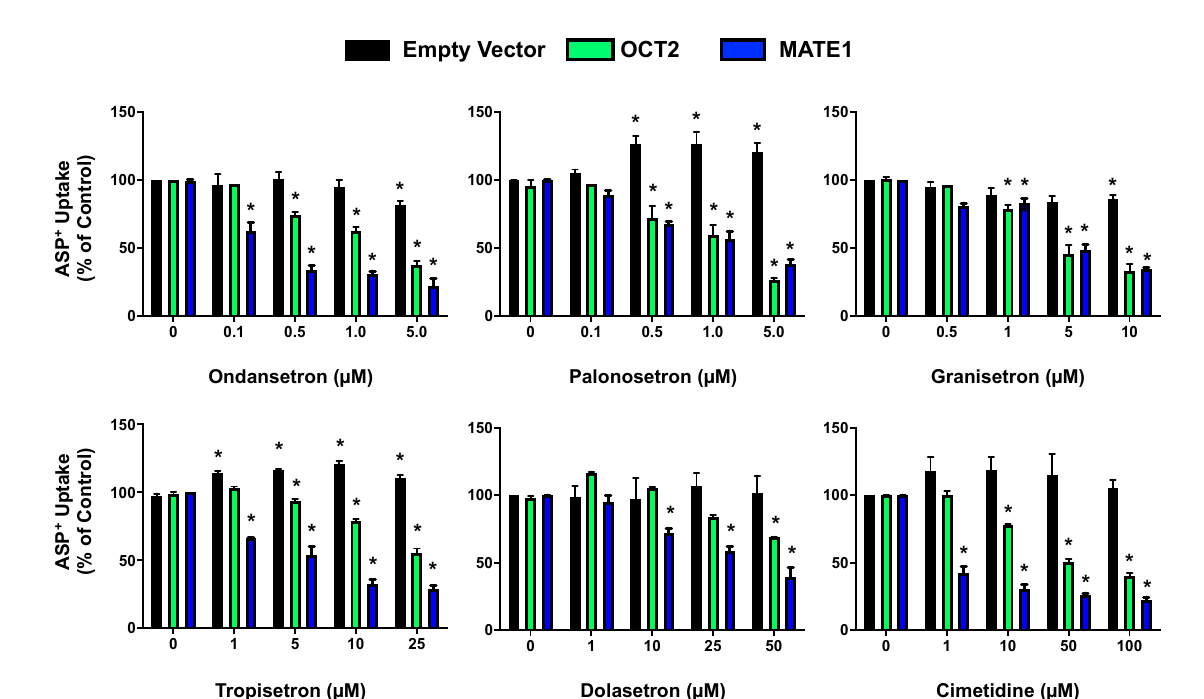
Figure 3. 5-HT 3 Antagonist Inhibition of ASP + Transport in HEK293 Cells Overexpressing OCT2 and MATE1 following 5-HT 3 Antagonist Treatment. Cells were incubated with ASP + (10 µ M) in the presence and absence of various concentrations of 5-HT 3 antagonist or the positive control inhibitor, cimetidine. Fluorescence was quantified and normalized to protein concentration. Fluorescence quantified in empty vector, OCT2, and MATE1 treated with vehicle control (no inhibitor) was set to 100%. Data are expressed as mean ± SE ( n = 3). * p < 0.05 compared to the vehicle.